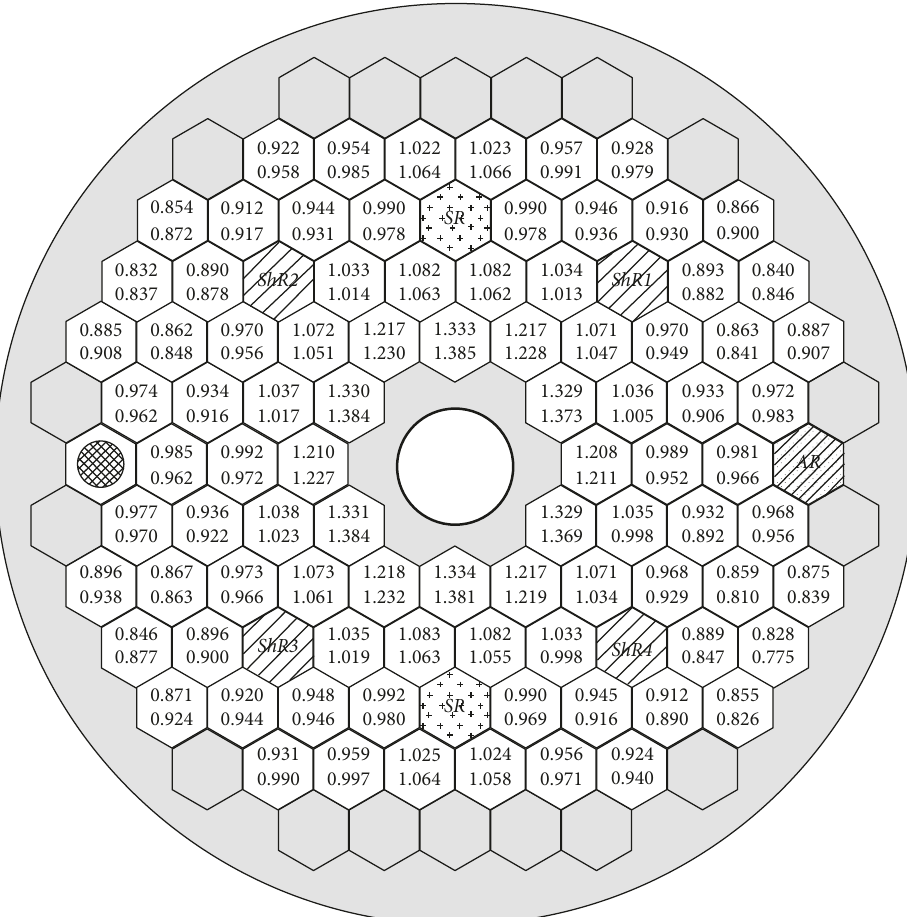
Figure 7: Relative power distribution in the case of complete withdrawal of the control rods. The upper and lower values were obtained with SRAC and MCNP5, respectively.